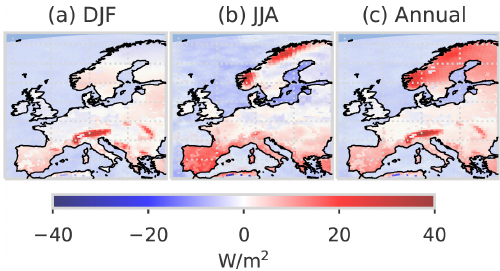
Figure 7. Changes in the TOA energy balance between CARBON and GRASS for (a) winter, (b) summer, and (c) the whole year.